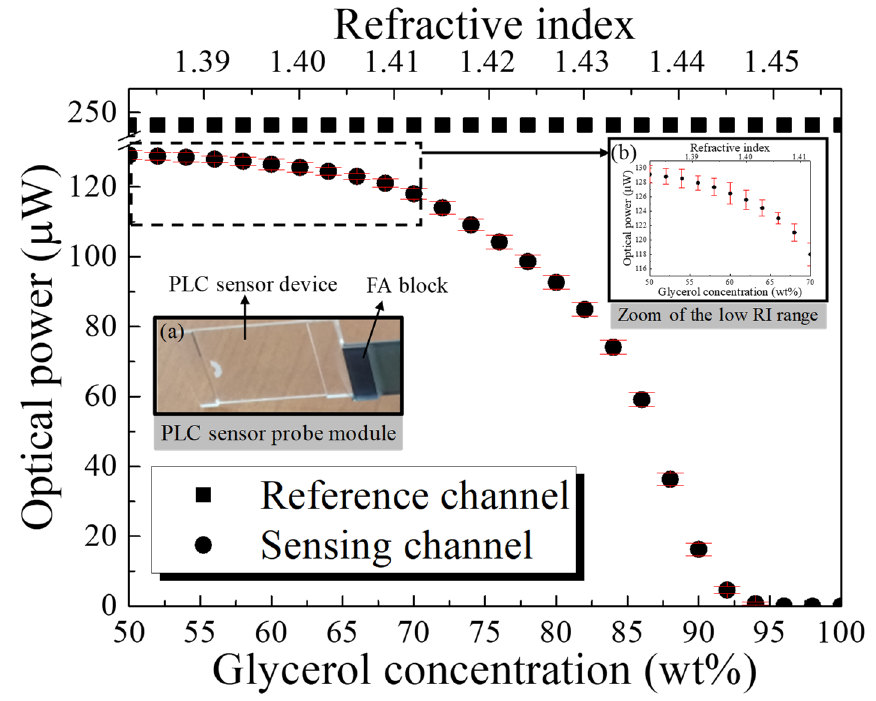
Figure 6. Optical characteristics of the PLC sensor probe, according to the RI. (Inset figures: ( a ) pig- tailed PLC sensor probe module; ( b ) zoom of the low RI range).